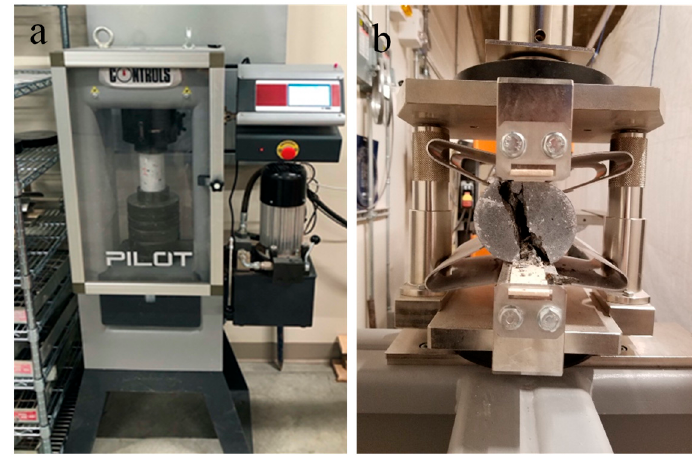
Figure 3. Setup for ( a ) compression, and ( b ) split tensile test.